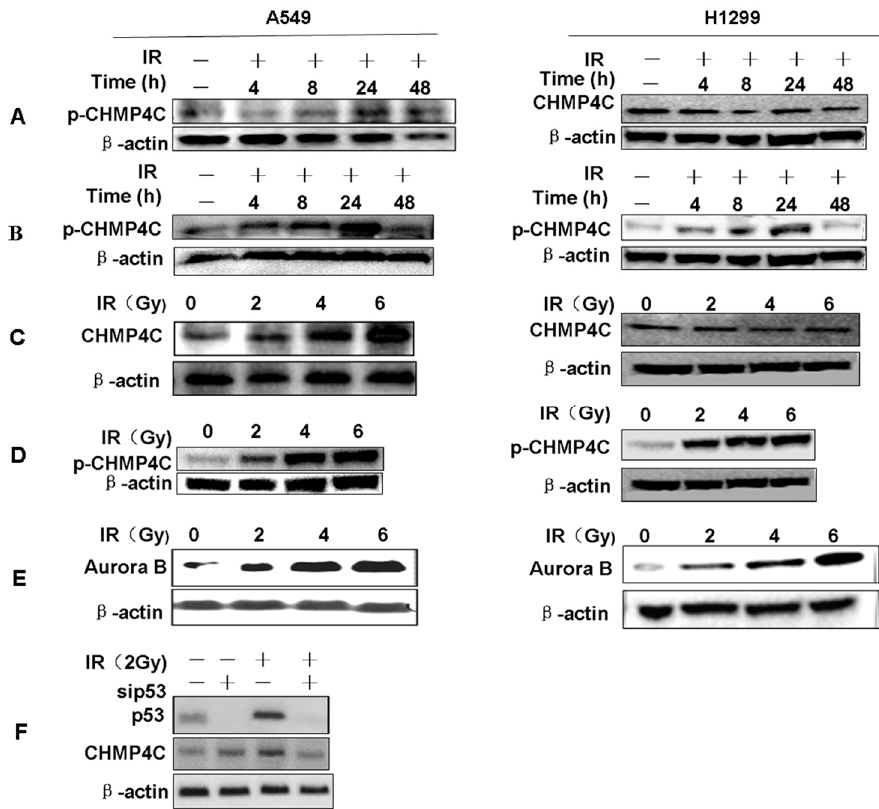
Figure 1. Radiation induces CHMP4C expression and phosphorylation. ( A , B ) The A549 or H1299 cells were irradiated with 2 Gy, and harvested at 4, 8, 24 and 48 h. CHMP4C expression or phosphorylation level was tested by Western blot using indicated antibodies; ( C , D ) Western blot analysis of CHMP4C expression or phosphorylation level at 24 h after treated with 2, 4, and 6 Gy IR in A549 or H1299 cells; ( E ) Aurora B expression level was tested by Western blot at 24 h after cells exposure to 2, 4, and 6 Gy IR; ( F ) Western blot analysis of expression of CHMP4C and P53 after p53 silencing with or without IR (2 Gy) in A549 cells.